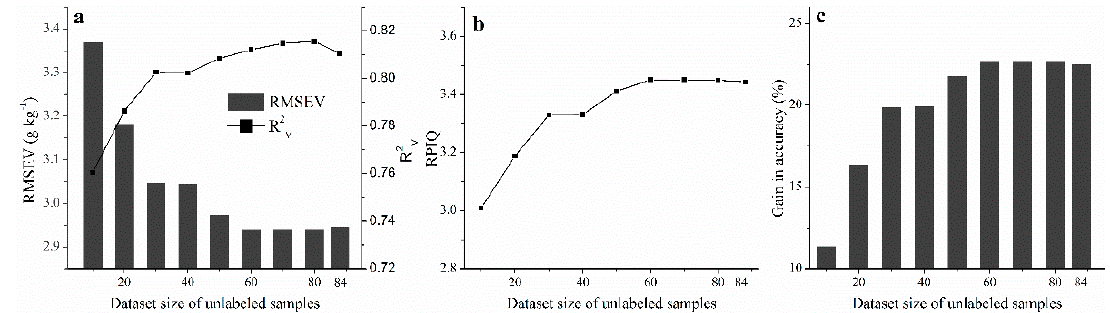
Figure 13. The performance of: Co-LSSVMR ( a ); RPIQ of Co-LSSVMR ( b ); and the gains in accuracy obtained by Co-LSSVMR with respect to LSSVMR ( c ) versus the pool size of labeled samples with 80 labeled samples used in calibration.